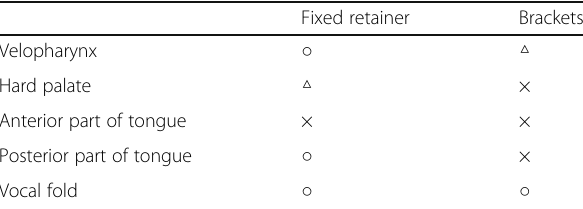
Table 5 Visibility of each organ in subjects wearing orthodontic appliances Fixed retainer Brackets